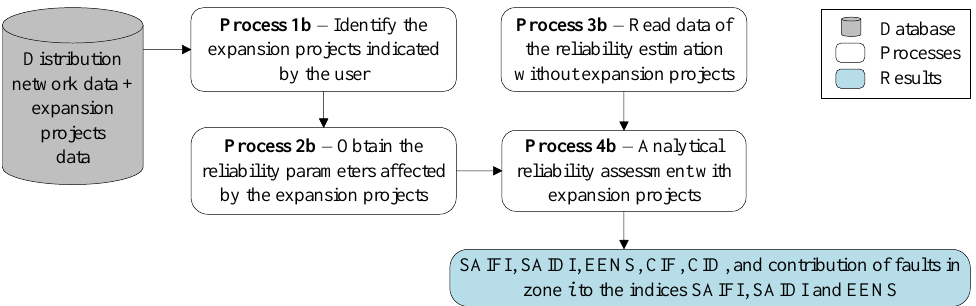
Figure 2. Flowchart for the estimation of reliability considering expansion